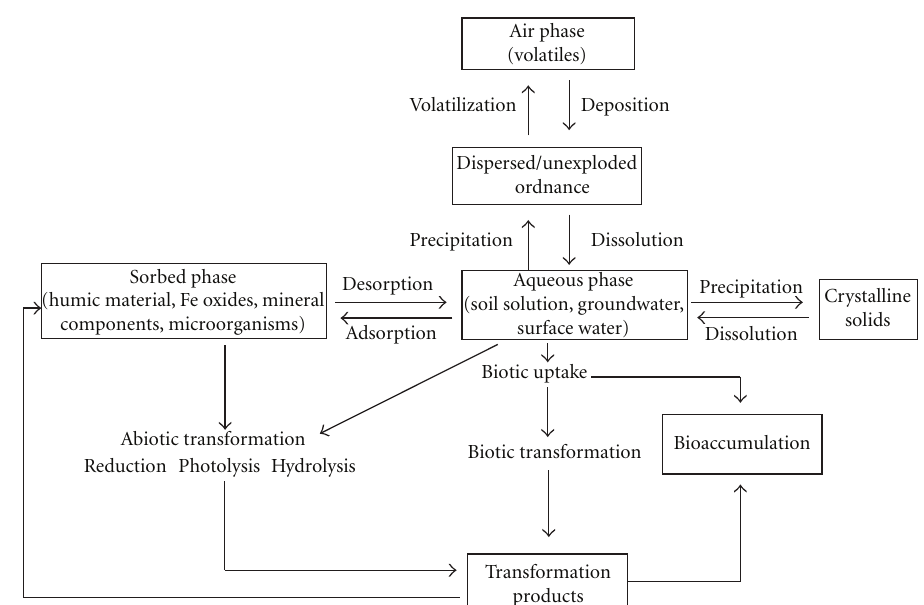
Figure 3: Suggested fates of energetic compounds in the environment [33, 36,